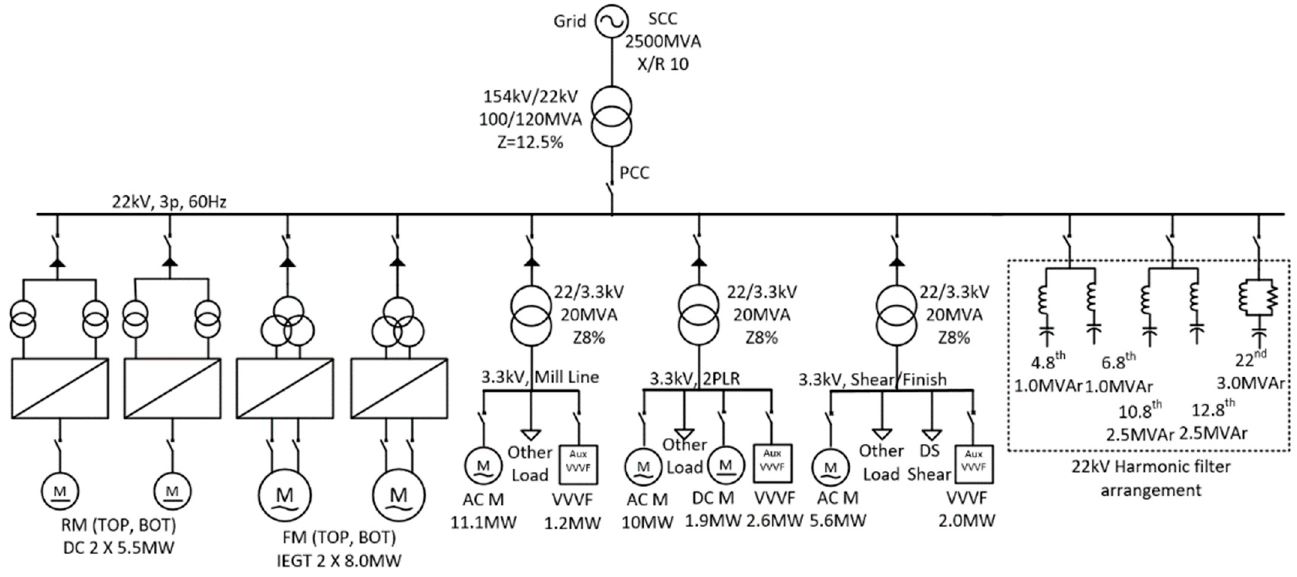
Figure 2. Simplified plate mill system single line drawing.